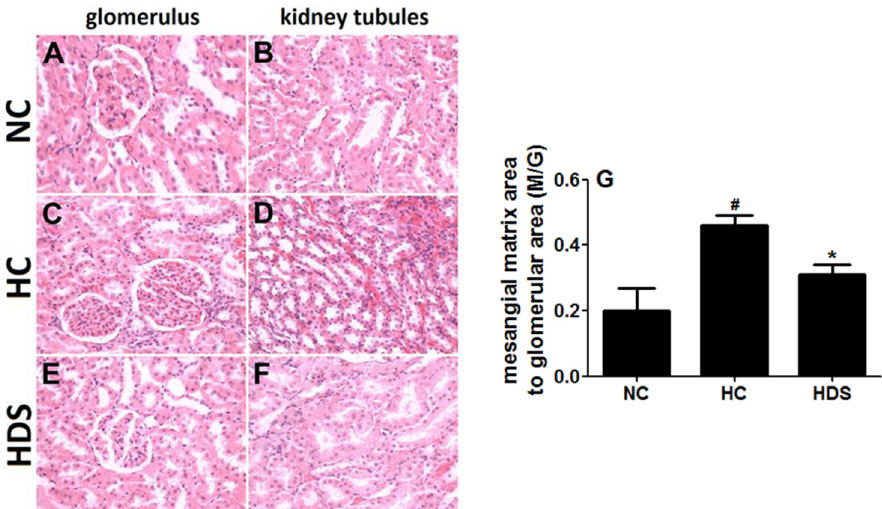
Figure 3. HE staining of renal tissues of rats in different groups. Glomerulus (left) and kidney tubule (right) tissues of rats in the NC group ( A , B ) HC group ( C , D ) and HDS group ( E , F ) (magnification ×400); ( G ) mesangial matrix area to glomerular area (M/G) ratio in different groups. # p < 0.05 compared with the NC group; * p < 0.05 compared with the HC group.